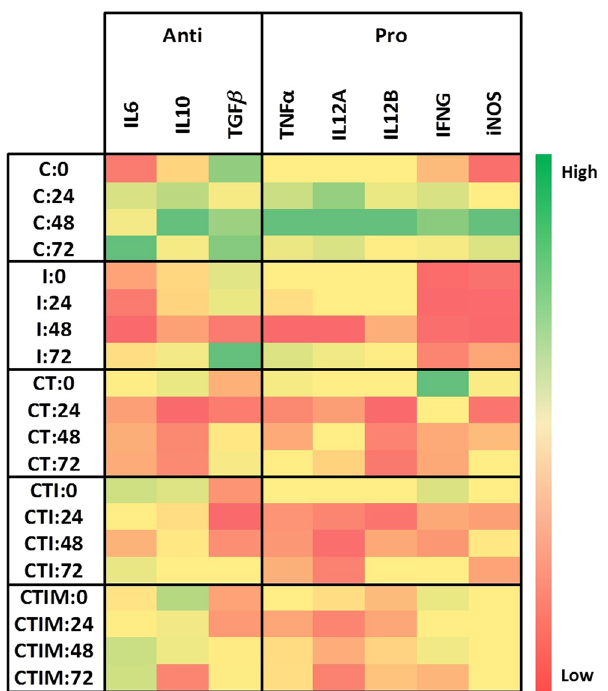
Figure 9. Cytokine analysis by qPCR between the treatment groups compared to the untreated control